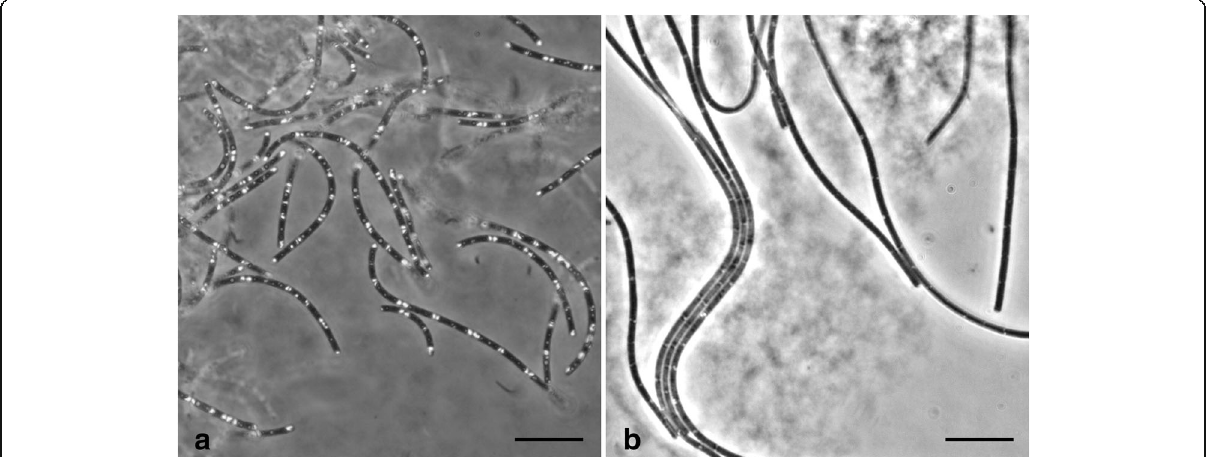
Fig. 1 Morphological features of ‘ Candidatus Chloroploca asiatica ’ B7 – 9 ( a ) and ‘ Candidatus Viridilinea mediisalina ’ Kir15-3F ( b ) as observed on